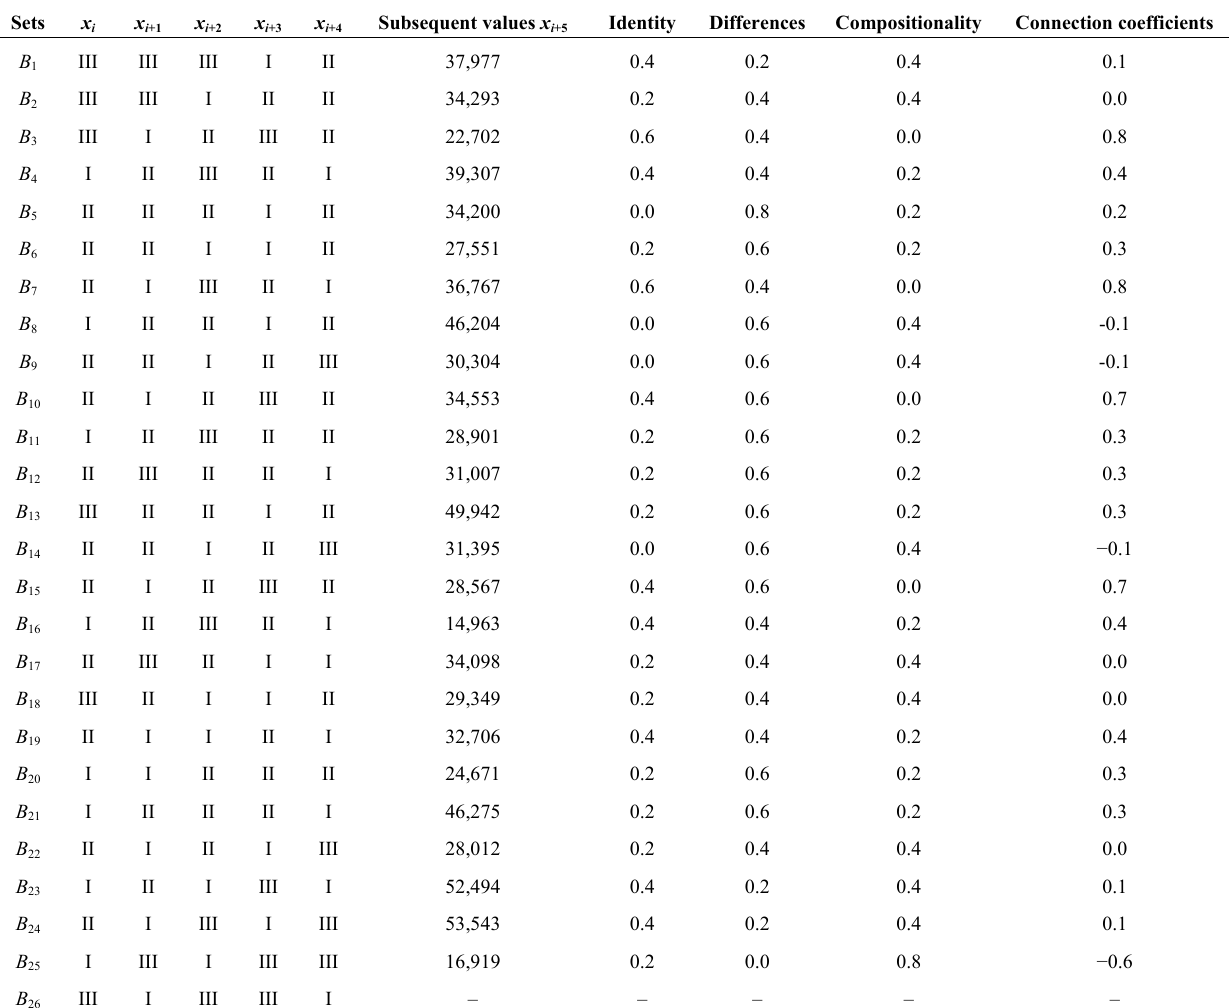
Table 3. The calculation process of forecasting annual runoff for the Hualien Bridge station in 2003.